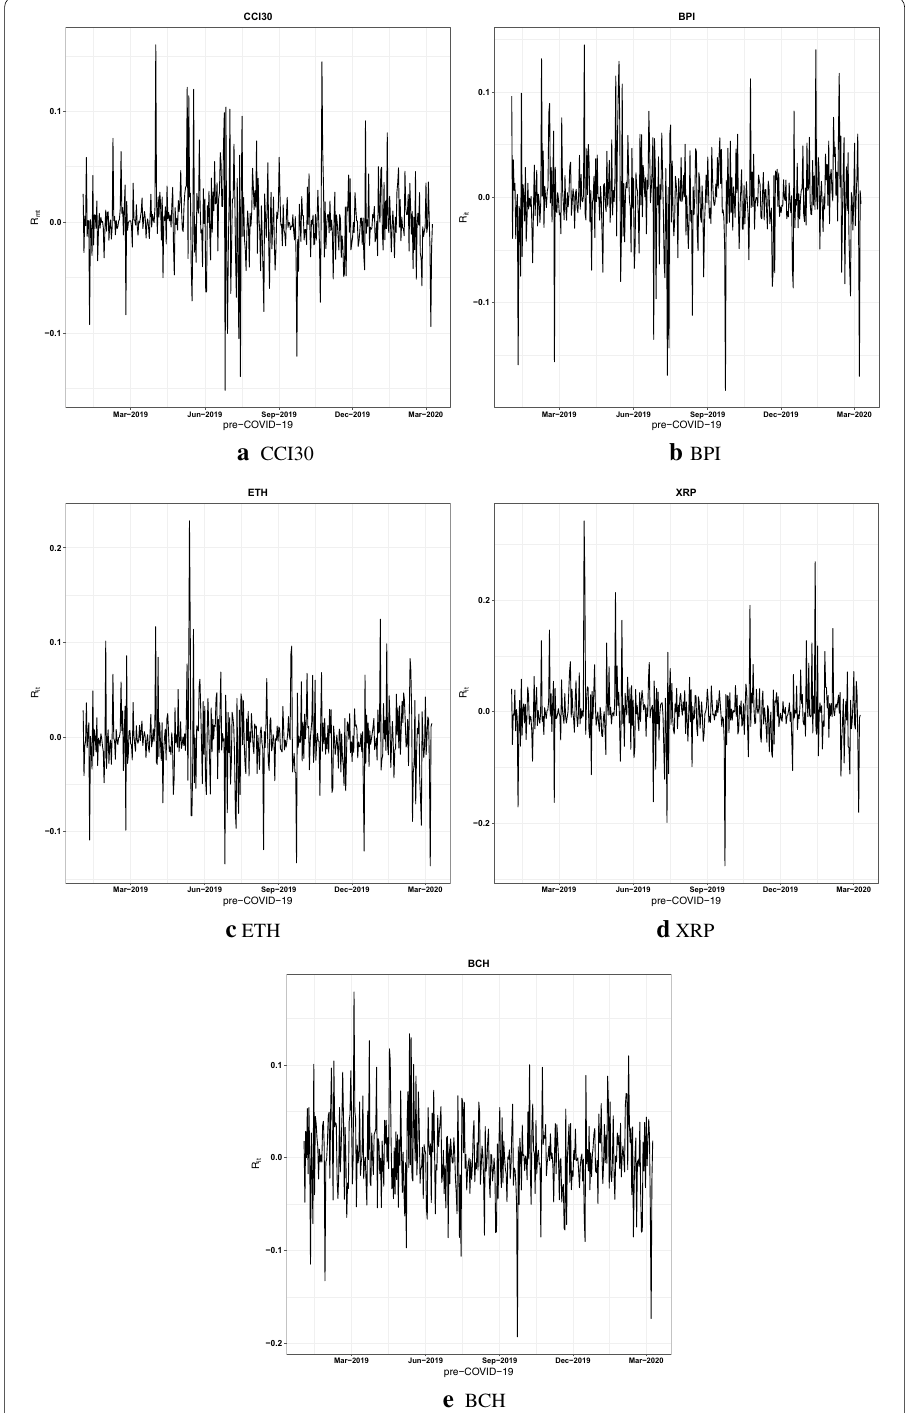
Fig. 1 Time series plots of the CCI30 and four cryptocurrencies’ returns during the pre-COVID-19